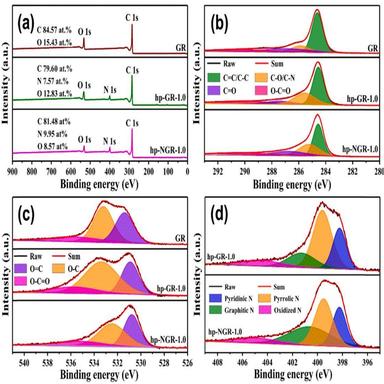
XPS survey spectra of GR, hp-GR-1.0 and hp-NGR-1.0 (a), and the corresponding high-resolution XPS spectra of C 1s (b), O 1s (c) and N 1s (d).